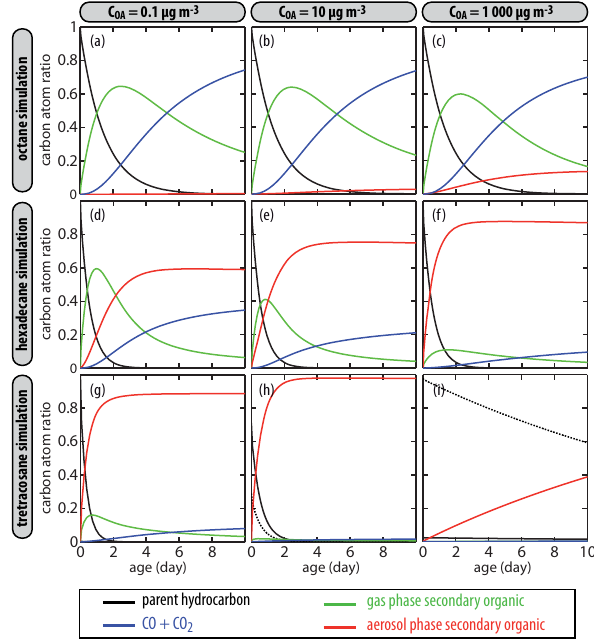
Fig. 1. Carbon budget during the oxidation of octane (top line) hex- Figure 1: Carbon budget during the oxidation of octane (top line) hexadecane (middle line) and adecane (middle line) and tetracosane (bottom line) for C OA con- tetracosane (bottom line) for C OA concentration of 0.1 μ g m ‐ 3 (1 st column), 10 μ g m ‐ 3 (2 nd column) and centration of 0.1µgm − 3 (1st column), 10µgm − 3 (2nd column) and 10 3 μ g m ‐ 3 (3 rd column). Continuous and dotted black lines in panels h and i denote the parent 10 3 µgm − 3 (3rd column). Continuous and dotted black lines in pan- compound in the gas phase and particulate phase, respectively. els h and i denote the parent compound in the gas phase and partic- ulate phase,